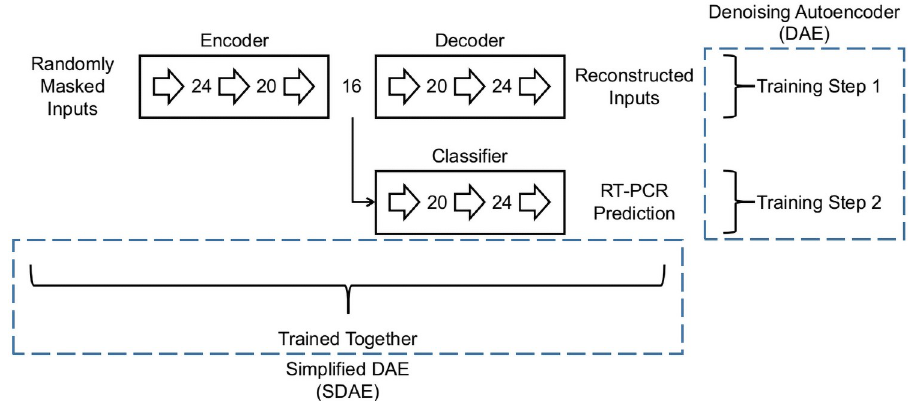
Fig 4. Architectures of DAE and SDAE. DAE trains the encoder and decoder first with the objective being to reconstruct masked inputs. The classifier is trained in a subsequent step using the features extracted from the encoder. In SDAE the decoder and classifier are trained together and the reconstruction loss is used as a regularizer for the classification. The numbers of neurons are indicated alongside the fully connected layers (large right arrows). Both models incorporate the efficiency constraint by the use of a bottleneck